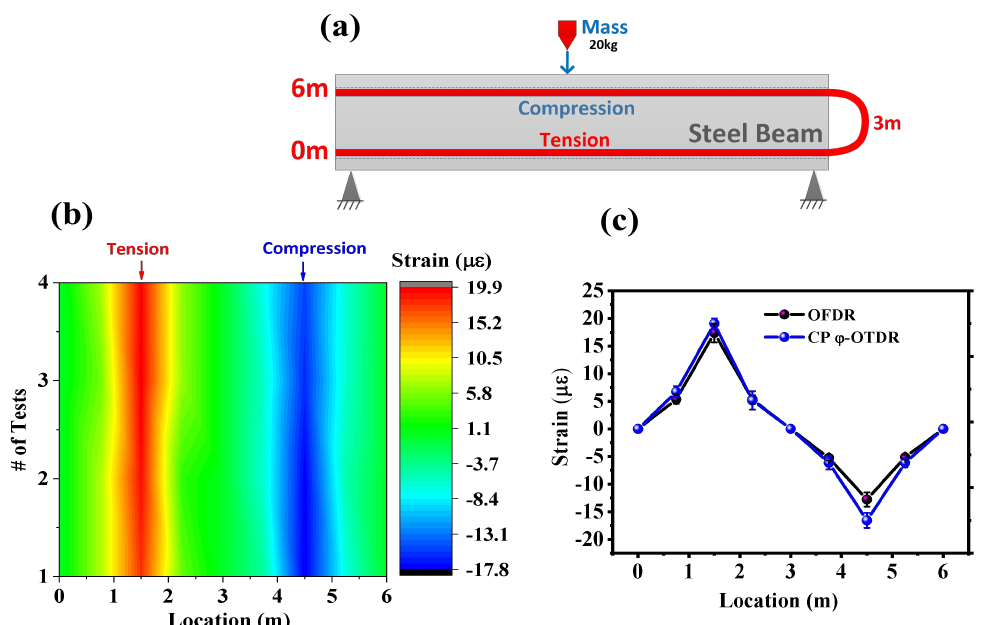
Figure 4. ( a ) layout for static strain measurement; ( b ) distributed static strain monitoring along the steel I − beam based on a chirped pulse ϕ − OTDR; ( c ) static strain distribution from OFDR and chirped pulse ϕ − OTDR system (1 m spatial